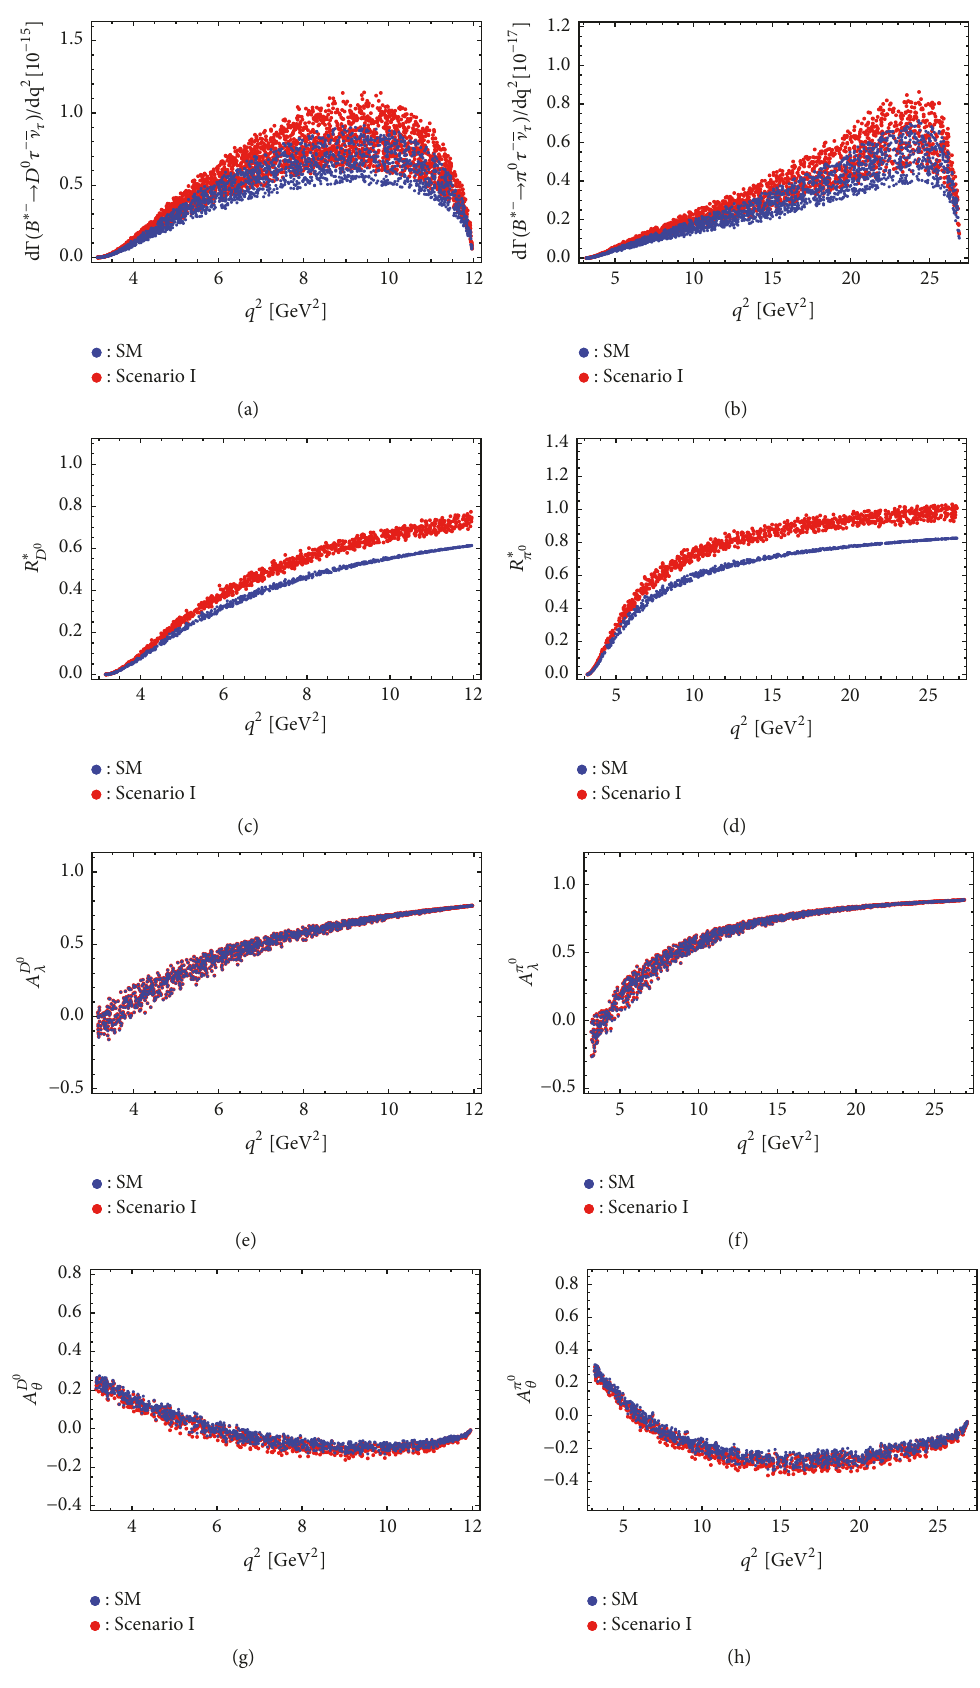
Figure 2: The 𝑞 2 -dependence of the differential observables 𝑑Γ/𝑑𝑞 2 , 𝑅 ∗ 𝑃 , 𝐴 𝑃 𝜆 , and 𝐴 𝑃 𝜃 for 𝐵 ∗− 󳨀→ 𝐷 0 𝜏 − ] 𝜏 and 𝜋 0 𝜏 − ] 𝜏 decays within the SM and scenario